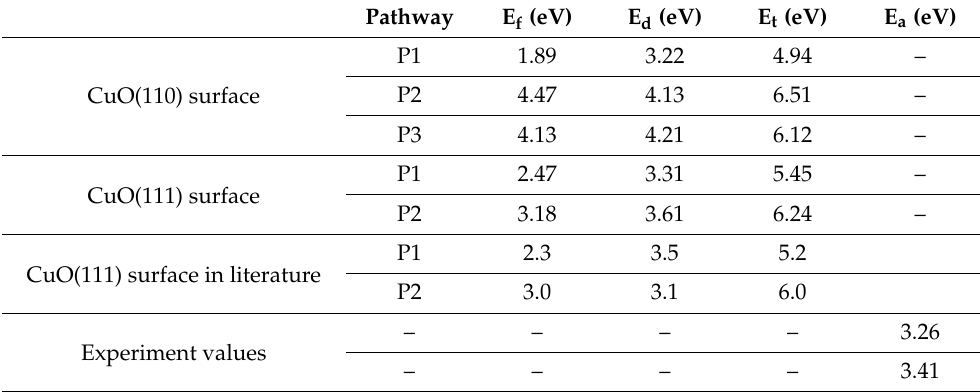
Figure 5. Potential energy diagram for the O 2 formation and desorption processes following different pathways on the CuO(111) surface. Table 1. The energy barriers of O 2 formation (E f ), O 2 desorption (E d ), total energy (E t ), and activation energy (E a ).